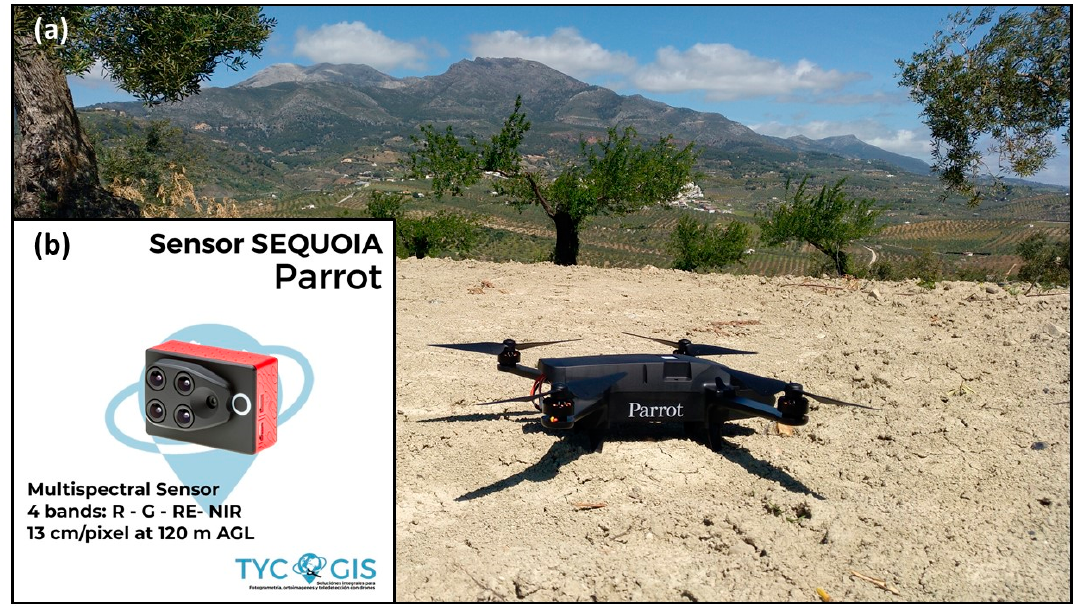
Figure 3. UAV quadcopter (a) and multispectral sensor (b).